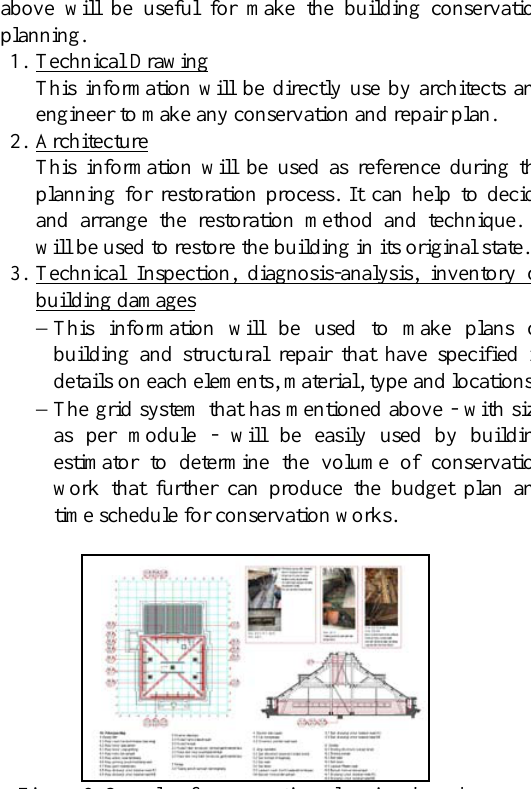
Figure 6. Sample of conservation planning, based on documentation of damage inventory and mapping. PDA project for Bank Indonesia ex De Javasche Bank in Solo, 2009.